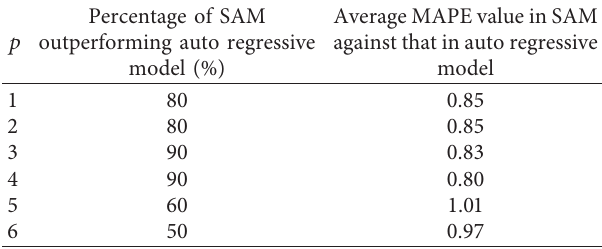
Table 6: Analysis of experiment results.